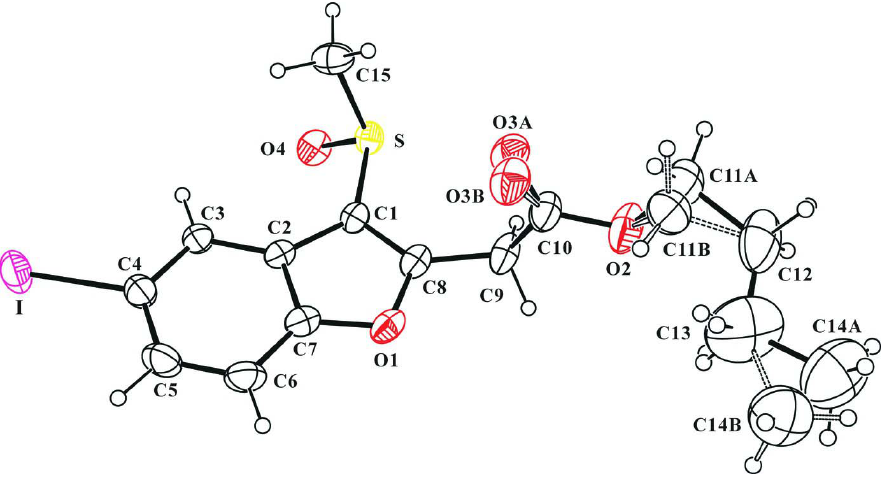
The molecular structure of the title compound, showing displacement ellipsoids drawn at the 30% probability level. The oxygen atom of carbonyl group and butyl group are disordered over two positions with site–occupancy factors, from refinement of 0.55 (4) and 0.45 (4) (for the O atom), 0.76 (2) and 0.24 (2) (for the butyl group),